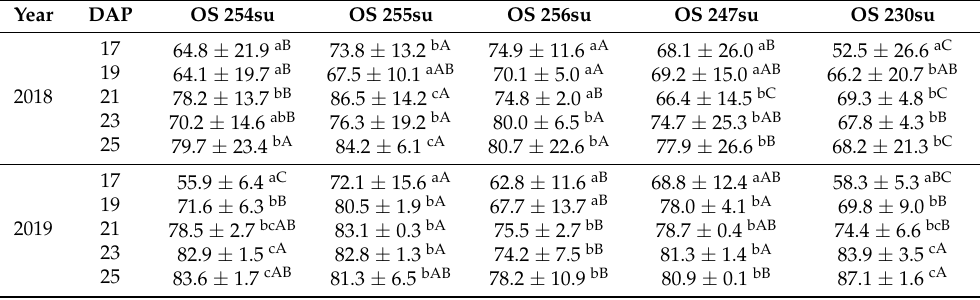
Table 6. DPPH radical scavenging activity (%) in five su1 sweet corn hybrids at five harvest dates (17–25 DAP) in two growing seasons (Osijek, 2018 and 2019). The different lowercases show signifi- cant differences among the harvest dates within hybrids ( p < 0.05). The different capital letters show significant differences among the hybrids ( p <